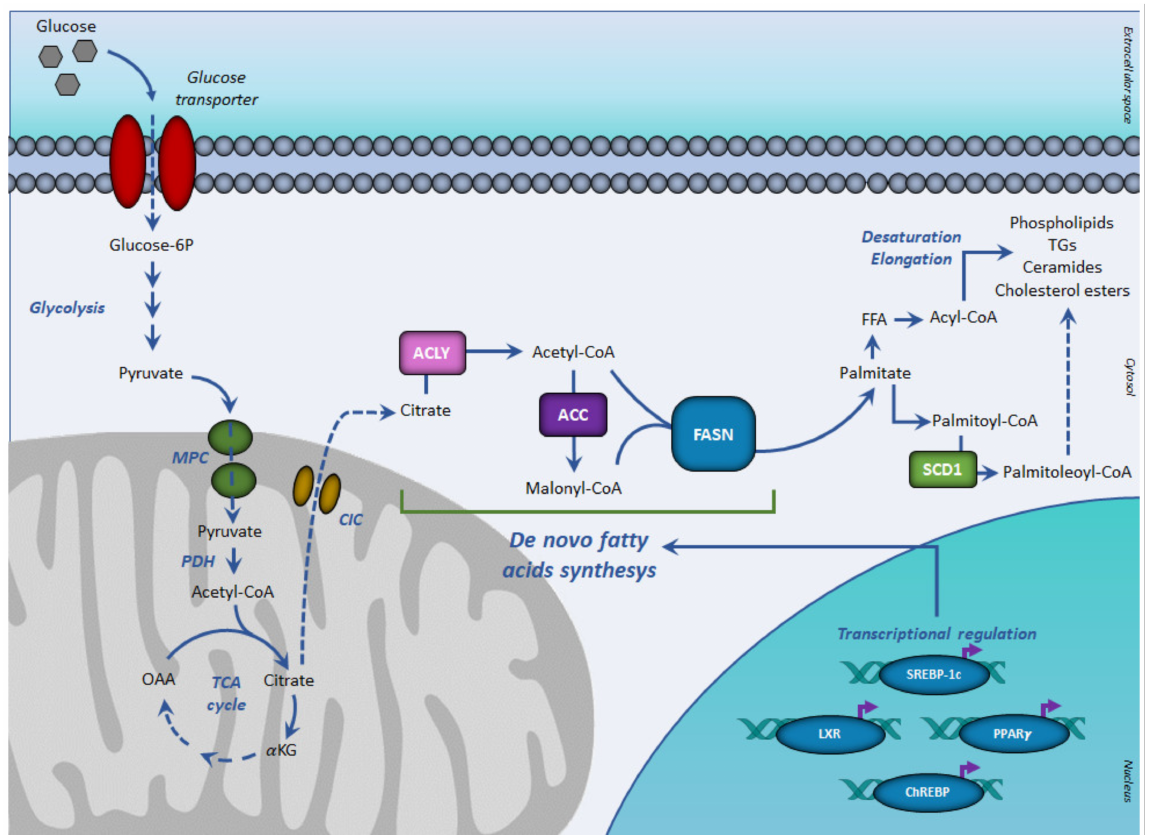
Figure 1. De novo lipogenesis and transcriptional regulation. In aerobic conditions, glucose-derived pyruvate fuels, in the form of acetyl-CoA, the tricarboxylic acid cycle, to form citrate. Once exported in the cytosol, citrate generates acetyl-CoA for fatty acid synthesis, mediated by sequential reactions of acetyl-CoA carboxylase and fatty acid synthase. The resulting palmitoyl-CoA is used for the synthesis of complex lipids. The de novo fatty acids synthesis is regulated at the transcriptional level by the SREBP-1c, PPAR γ , ChREBP, and LXR receptor family. Abbreviations: ACC, acetyl-CoA carboxylase; ACLY, ATP citrate lyase; ChREBP, carbohydrate-responsive element-binding protein; CIC, citrate carrier; FASN, fatty acid synthase; FFA, free (non-esterified) fatty acid; α KG, α -ketoglutarate; LXR, liver X receptor; MPC, mitochondrial pyruvate carrier; OAA, oxaloacetate; PPAR γ , peroxisome proliferator-activated receptor- γ ; PDH, pyruvate dehydrogenase; SCD1, stearoyl-CoA desaturase; SREBP-1c, sterol regulatory element-binding proteins-1c; TCA, tricarboxylic acid